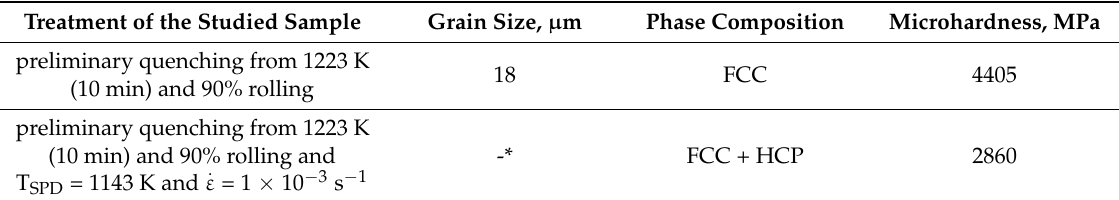
Table 3. Characteristics of microstructure features and results of mechanical tests depending on the conditions for sample preparation.